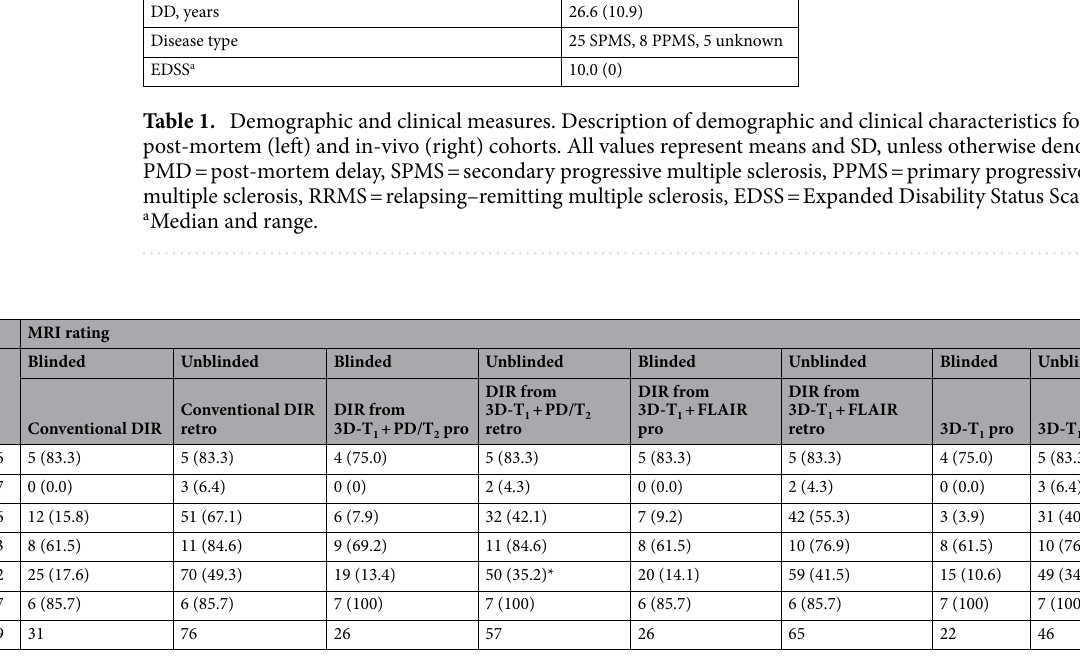
Table 1. Overviews of the imaging training results (i.e., input and output) are provided in Figures S1 and S2. A total of 142 cortical lesions were identified in 66 tissue samples. Of these lesions, 6 were type I, 47 were type II, 76 were type III and 13 were type IV. In addition, 7 white matter lesions were detected.